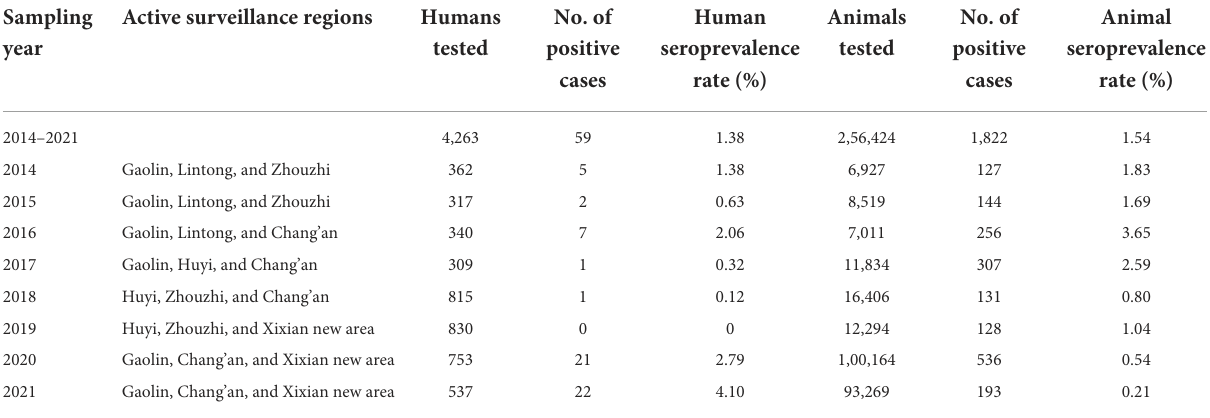
TABLE 2 Human and animal seroprevalence rates from serological investigations according to the Xi’an Brucellosis Prevention and Control Plan from 2014 to 2021. Sampling Humans